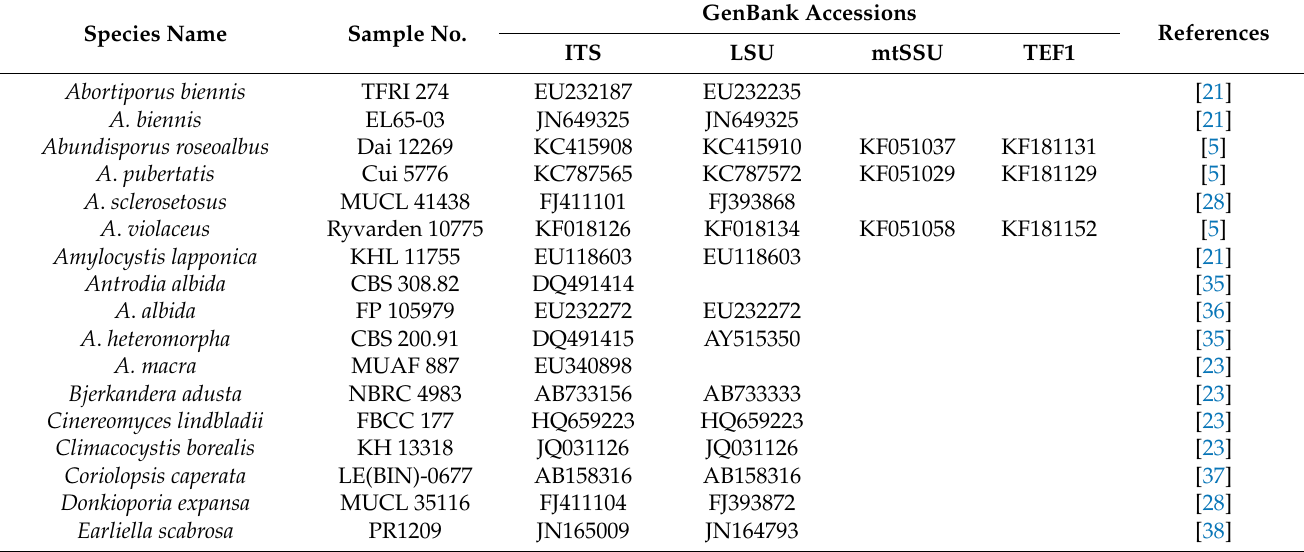
Table 1. Information of the sequences used in this